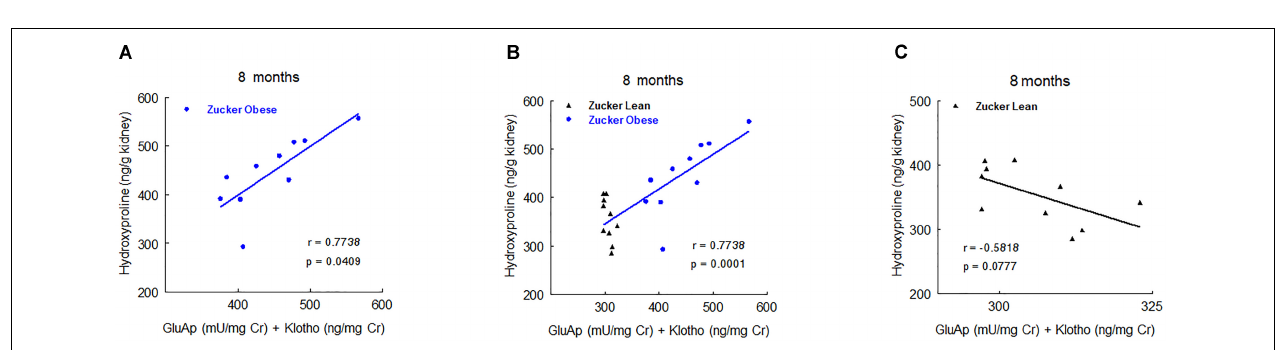
FIGURE 8 | Predictive correlations of the combination of GluAp and Klotho at 8 months old with renal hydroxyproline content at the end of the experiment in ZO rats ( A , n = 10), in ZL and ZO rats ( B , n = 20) and in ZL rats ( C , n = 10).